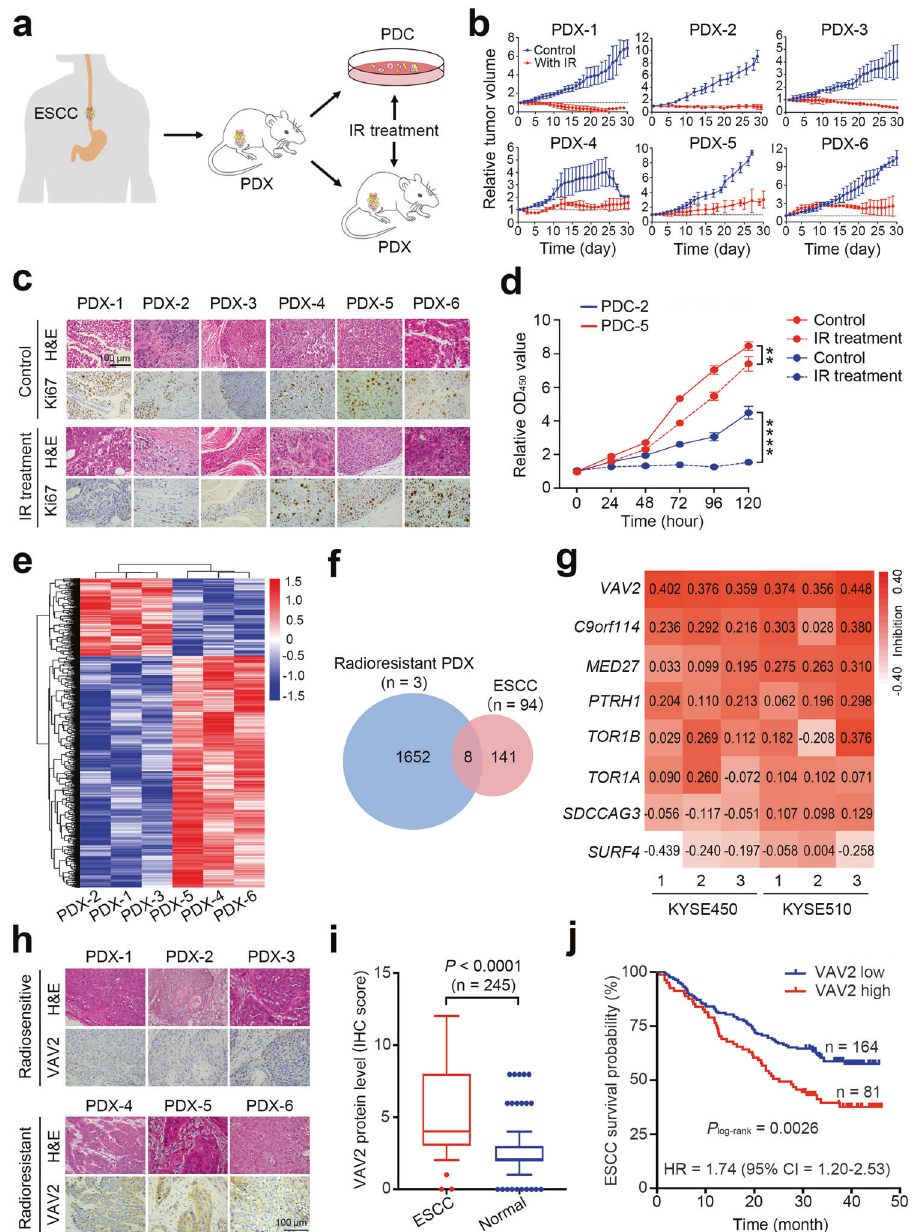
Fig. 1 VAV2 functions as a radioresistant oncogene in ESCC. a Schematic diagram for the constructions of patient-derived xenograft (PDX) of esophageal squamous-cell carcinoma (ESCC), PDX-derived cells (PDC) and irradiation (IR) treatment. b Growth curves of PDXs from 6 individuals with ESCC, showing different sensitivity to IR. Data at each time point are mean ± SD from 3 mice. c Hematoxylin-eosin (H&E) and immunohistochemical (IHC) staining of Ki67 in PDX tumors with or without IR. Scale bars, 100 µm. d Proliferation curves of PDC-2 and PDC-5 cells with or without IR (4 Gy), showing different sensitivity to IR. Data are mean ± SEM from 3 independent experiments and most error bars are with the symbols. ** P < 0.01 and **** P < 0.0001 of Student ’ s t -test. e Heat map showing th e differentially expressed genes detected by RNA-sequencing in radiosensitive or radioresistant PDXs. f Venn diagram displaying the overlapped genes among 1,660 apparently overexpressed genes in 3 radioresistant PDXs and 149 ampli fi ed and overexpressed genes in 94 clinical ESCC specimens as described previously. 16 g Heat map displaying the inhibitory effects of silencing 8 genes on the malignant phenotypes of two ESCC cell lines. The number presents the inhibitory ef fi ciency and each cell line had 3 independent replications. h H&E and IHC analysis of VAV2 protein level in radiosensitive or radioresistant PDXs. Scale bars, 100 µm. i Box and bar plots comparing the VAV2 protein levels between ESCC and non-tumor tissue samples. P of Mann – Whitney test. j Kaplan – Meier curves of patient survival according to the VAV2 IHC score in tumors. High, IHC score > 6 and low, IHC score ≤ 6. Also present with Kaplan – Meier plot is the hazard ratio (HR) and 95% con fi dence interval (CI) from multivariate Cox proportional hazard models, including age, sex, tumor stage as covariates (Fig. 3f – h); in contrast, knockout of VAV2 signi fi cantly increased γ - overexpression may promote DNA repair function. We found that H2AX levels in cells with or without IR (Supplementary Fig. S3h – j). VAV2 overexpression signi fi cantly reduced both spontaneous and DNA comet assays with primary ESCC cells PDC-4 and PDC-5 IR-induced DNA damages in ESCC cells as indicated by γ -H2AX showed that VAV2 silence by siRNA resulted in signi fi cantly more levels analyzed by Western blotting and immuno fl uorescence Signal Transduction and Targeted Therapy (2021)